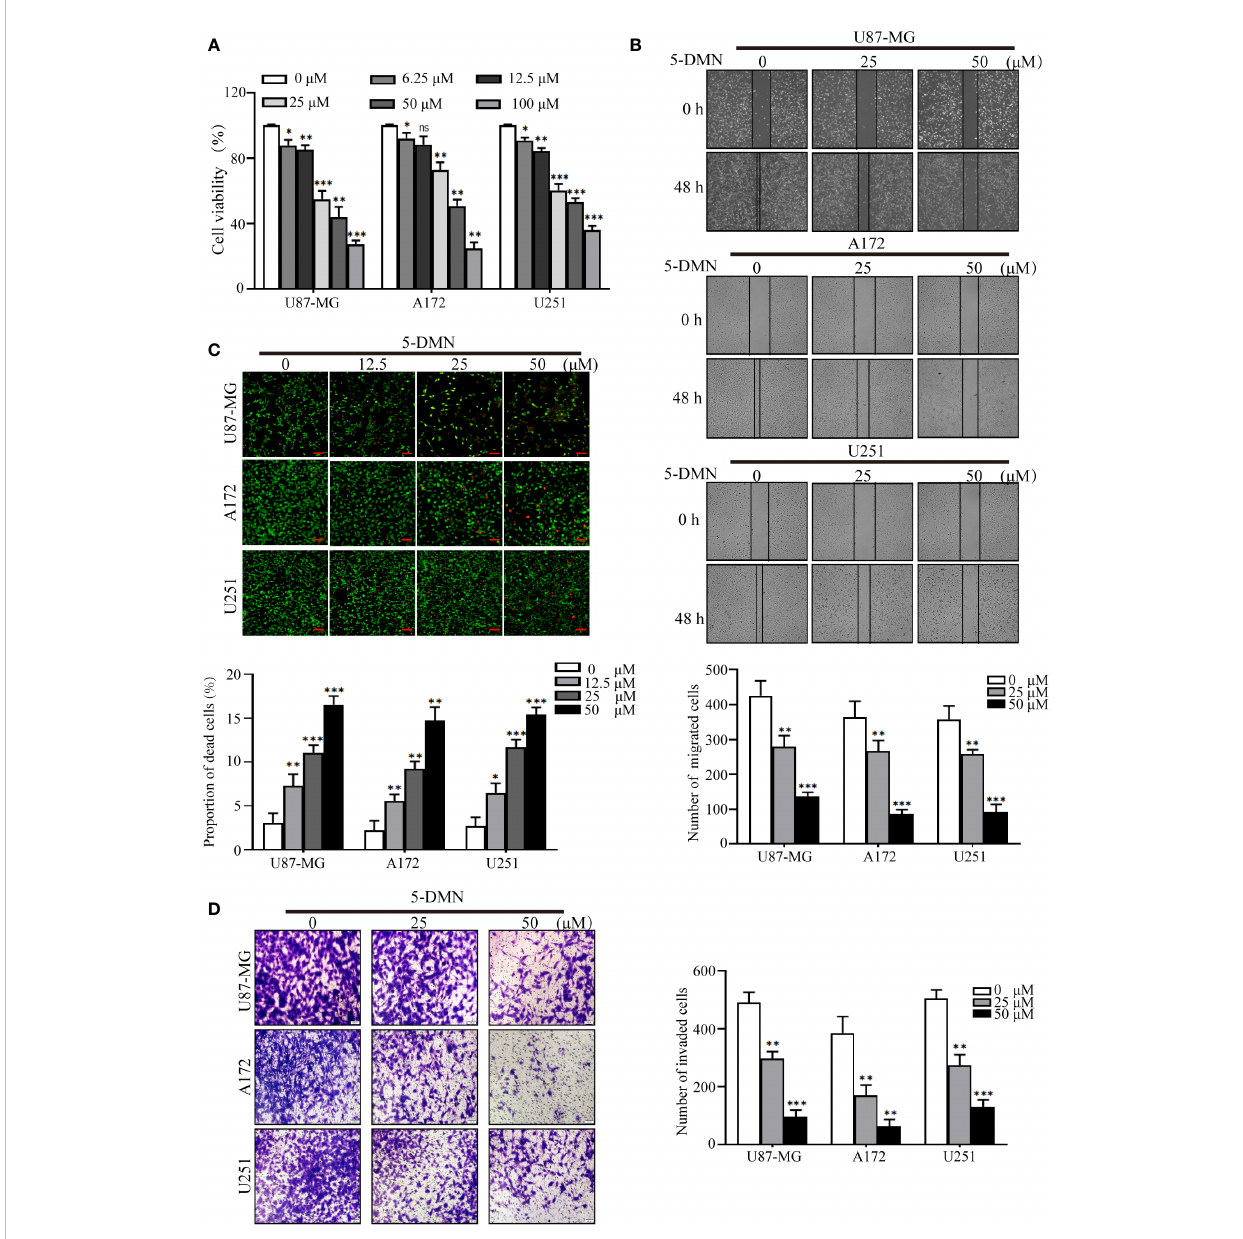
FIGURE 1 Inhibitory effects of 5-DMN on the viability, migration and invasion of GBM cells. (A) Cell viability was determined using the MTT assay after cultured U87-MG, A172, and U251 cells were incubated with various doses of 5-DMN for 48 h. (B) The merged image of live cells (green) and dead cells (red) in GBM cells treated with different concentrations of 5-DMN. Scale bar = 100 m m. (C) Wound healing assays were used to determine the migration ability of U87-MG, A172, and U251 cells after 48 h of incubation with 5-DMN (0, 25, 50 m M). (D) The invasion ability of GBM cells treated with or without 5-DMN (25, 50 m M) for 48 h was detected by transwell assays. Values are the means ± SD of three independent experiments. *p<0.05, **p<0.01, ***p<0.001 vs. cells in the untreated control group. ns, no signi fi